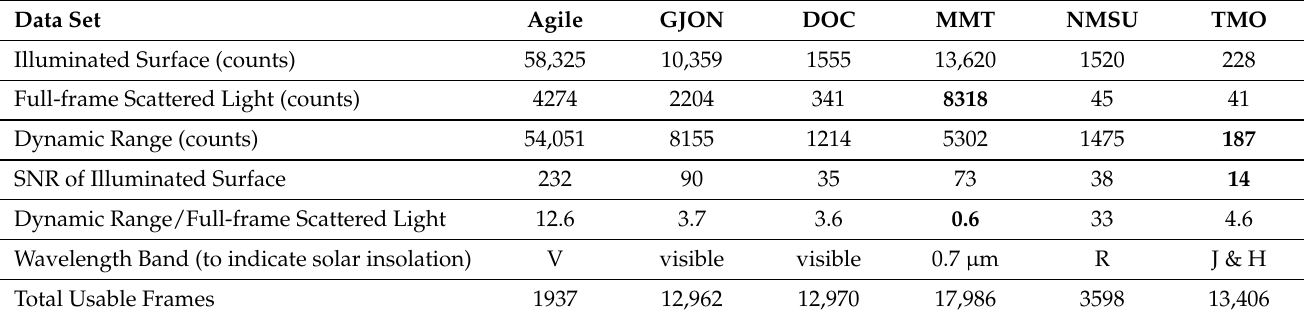
non-detection in that data